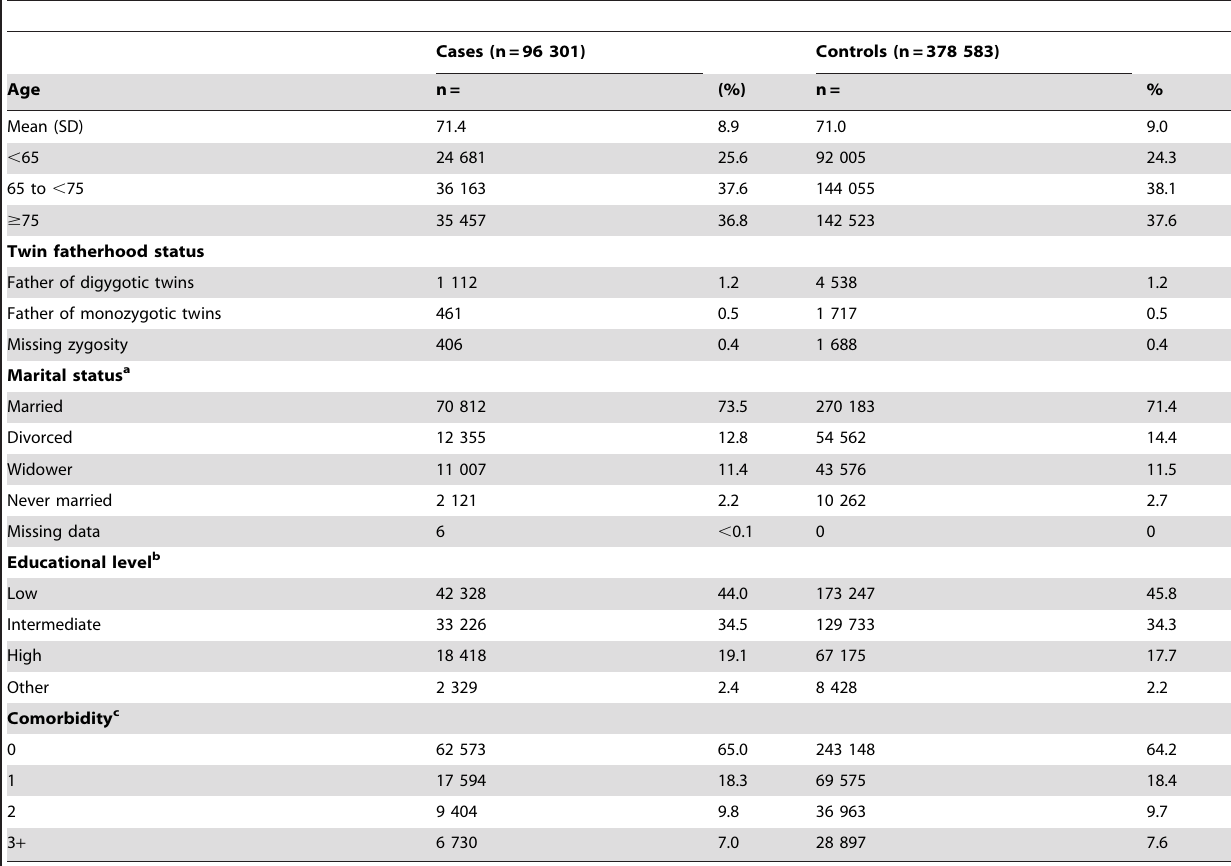
Table 1. Characteristics of cases and controls in Prostate Cancer database Sweden